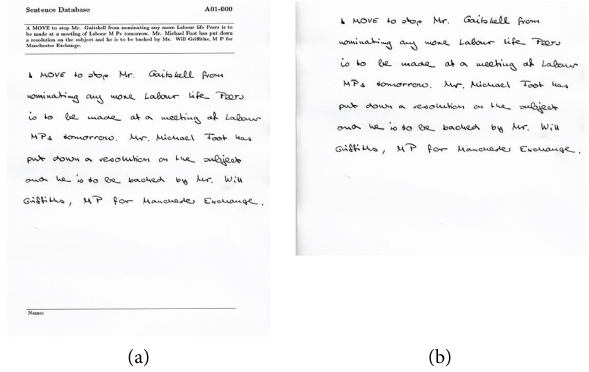
Figure 2: (a) Original image; (b) after the cropping